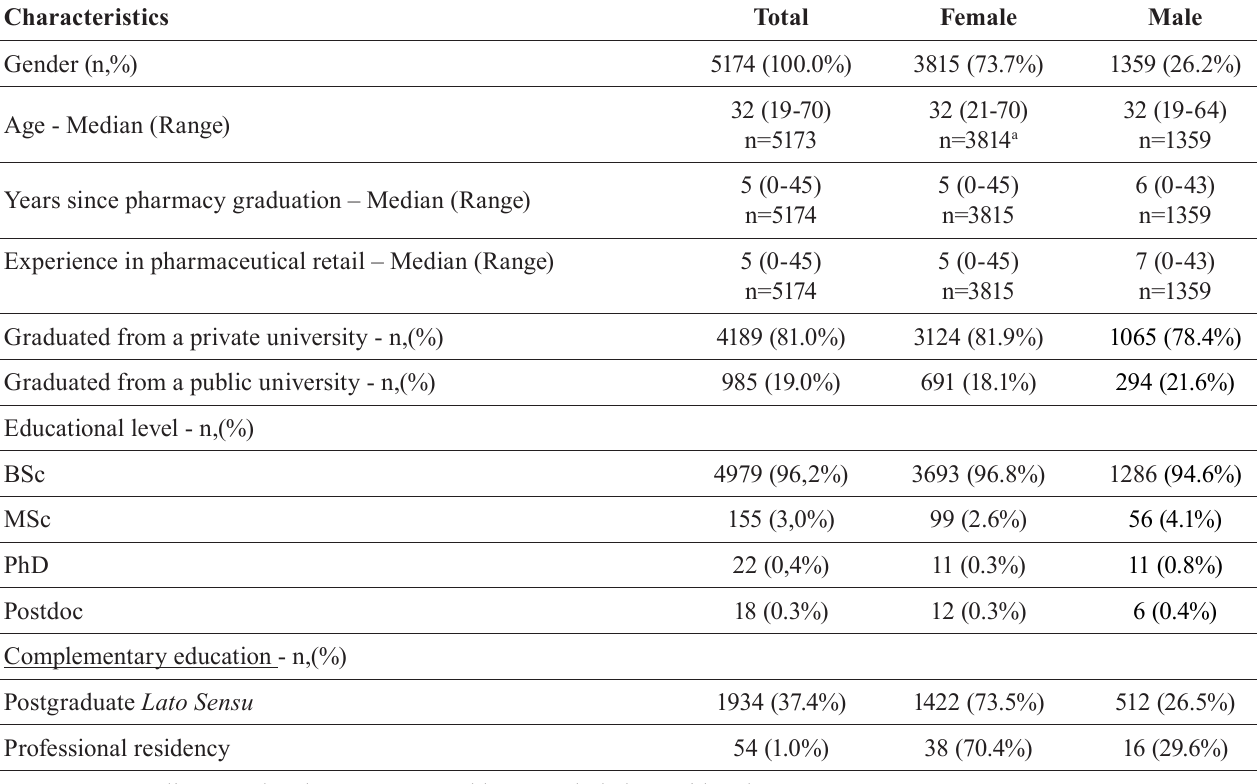
TABLE I - D emographic and other characteristics of the study sample (n=5174)